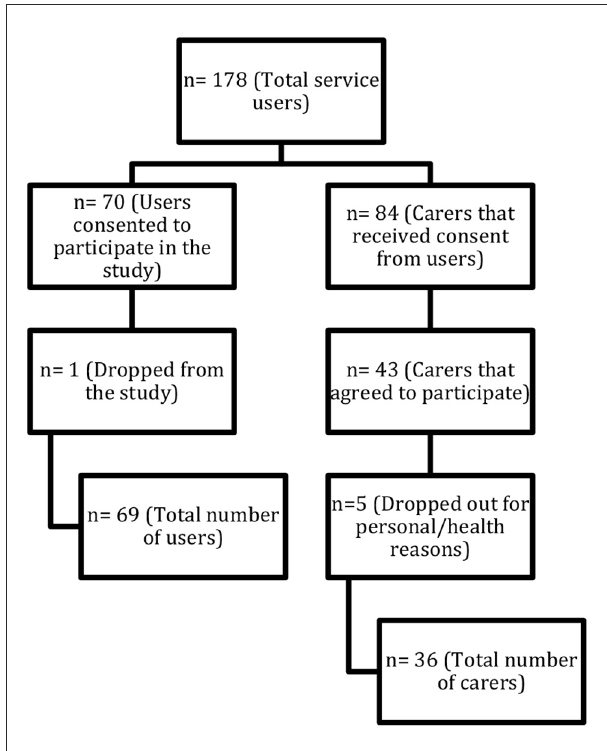
FIGURE1 Flowchart showing recruitment of participants for the